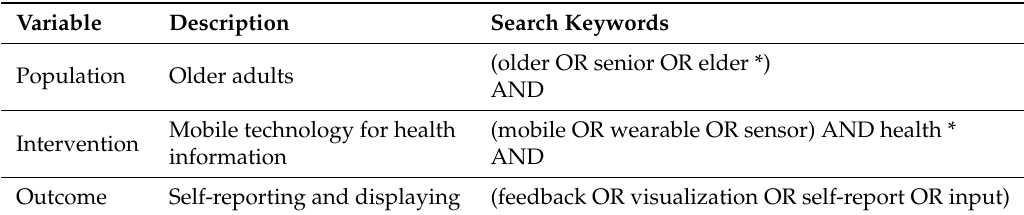
Table 1. Search keywords aligned to